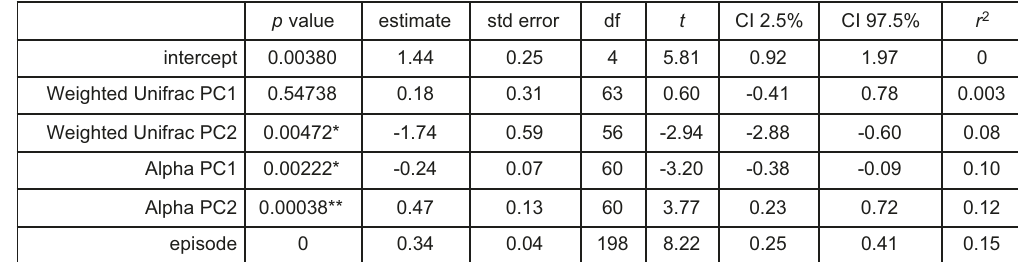
Fig. 4 Associations between 1-month microbiome and non-social fear behavior. a – e Scatterplots displaying relationships between alpha diversity principal component 2 at 1 month of age and average scores of bodily fear, escape behavior, facial fear, vocal distress, and startle response during the Mask Task paradigm at 1 year of age, respectively. Each dot represents a single subject. f Two-level linear mixed effects model with t test, **denotes signi fi cance after Bonferroni correction for multiple comparisons, threshold for signi fi cance of p = 0.00208, * denotes p < 0.05, n = 19 independent participants. Source data for this fi gure are provided as a Source Data fi